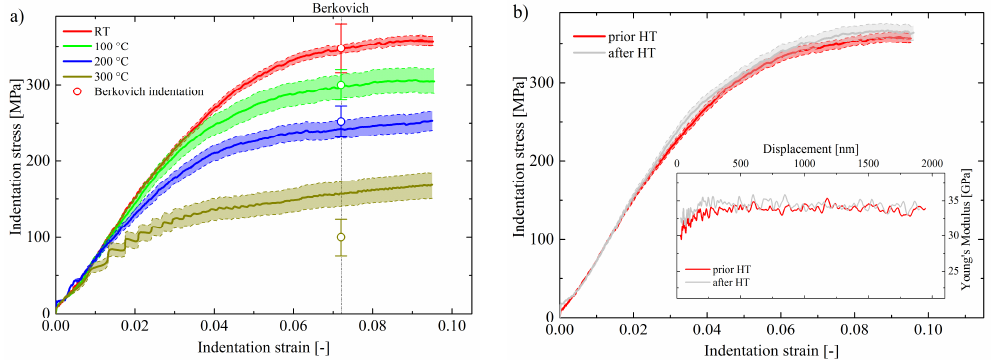
Figure 4. ( a ) Indentation flow curves with according deviations of NP Au at room and elevated temperatures. Except the data measured at 300 °C Berkovich indentation tests of previous studies coincide well with spherical measurements; ( b ) Comparison of measurements conducted prior and after HT exposure does not reveal any changes of the mechanical properties. The elastic modulus (inset) remains unaffected by re-annealing.